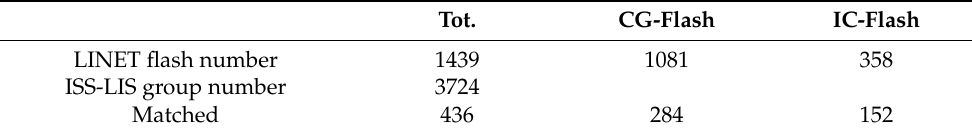
Table 2. LINET and ISS-LIS groups matched as different categories and with the flash number in each category. Data were compared for a 100-km region around Mt. Cimone, from January 2020 to December 2020. LINET useful flashes were selected in each corresponding view time LIS observation. The correlation criteria made use of space and time windows of 20 km and 10 ms, respectively.